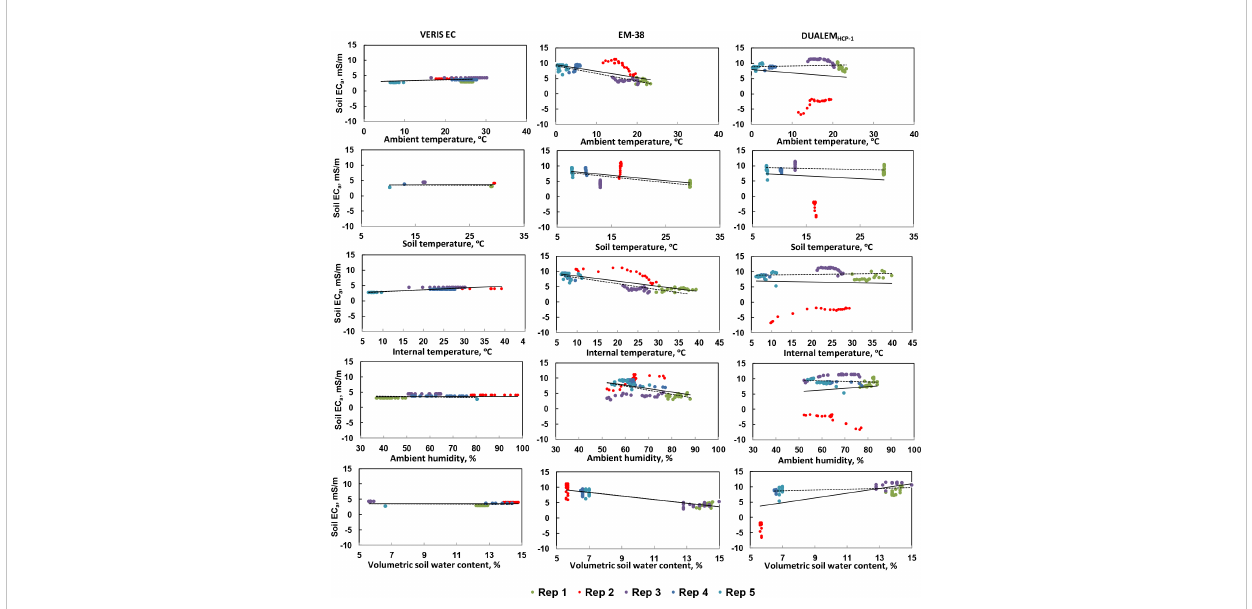
FIGURE 8 Examples of relationships between EC a measurements (15-min sampling) and corresponding records of ambient conditions (dash lines show regressions with 18-Sep data excluded). Rep 1 through Rep 5 represents the test replication on different test events.